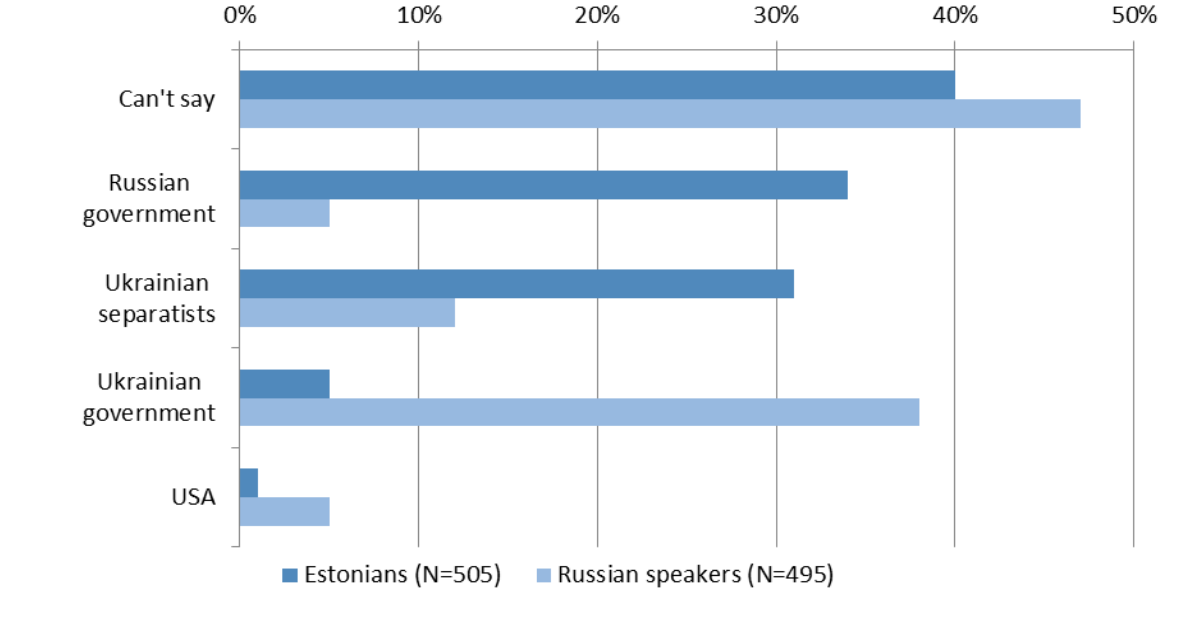
Figure 3. Response to the question: In your opinion, who is responsible for shooting down the Air Malaysia plane? (N = all respondents. Since each respondent could give more than one answer, the sum of percentage can be over 100). Source: Saar Poll (2014, Figure 19).